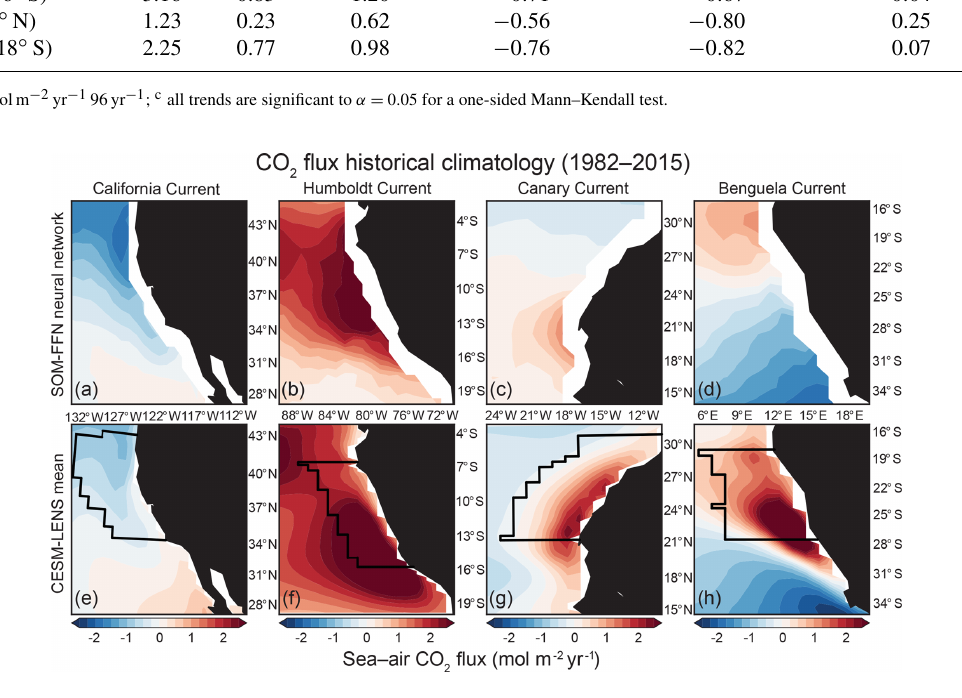
Figure 1. Comparison of CO 2 flux climatology from 1982–2015 between the SOM-FFN (a–d) and the CESM-LENS (e–h) . Red denotes outgassing of CO 2 from the ocean to the atmosphere, while blue represents uptake of CO 2 by the ocean. Black lines in (e) – (h) follow the model grid and show the region used in each EBUS for statistical analysis, which is based on the 10 ◦ latitude of most active upwelling from Chavez and Messié (2009) and is confined to 800km offshore in the E–W